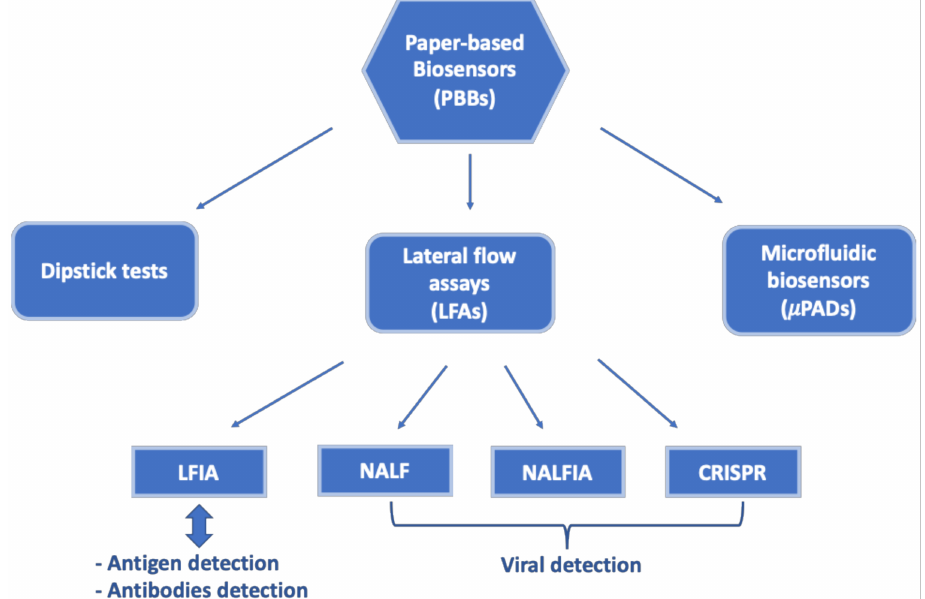
Figure 2. Schematic classification of PBBs. Abbreviations: LFIA = lateral flow immunoas- say; NALF = nucleic acid lateral flow; NALFIA = nucleic acid lateral flow immunoassay; CRISPR = clustered regularly interspaced short